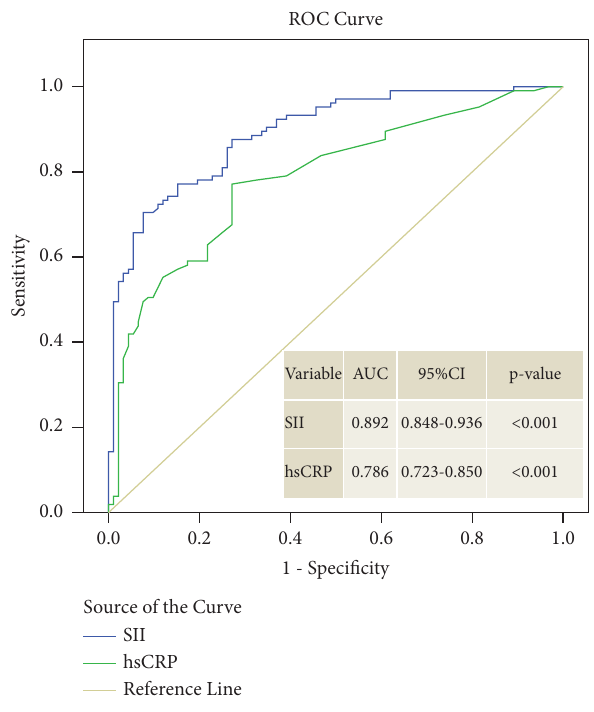
Figure 2: Receiver operating characteristic (ROC) curve analysis of systemic immune-infammation index (SII) and high-sensitivity C- reactive protein for the prediction of coronary slow